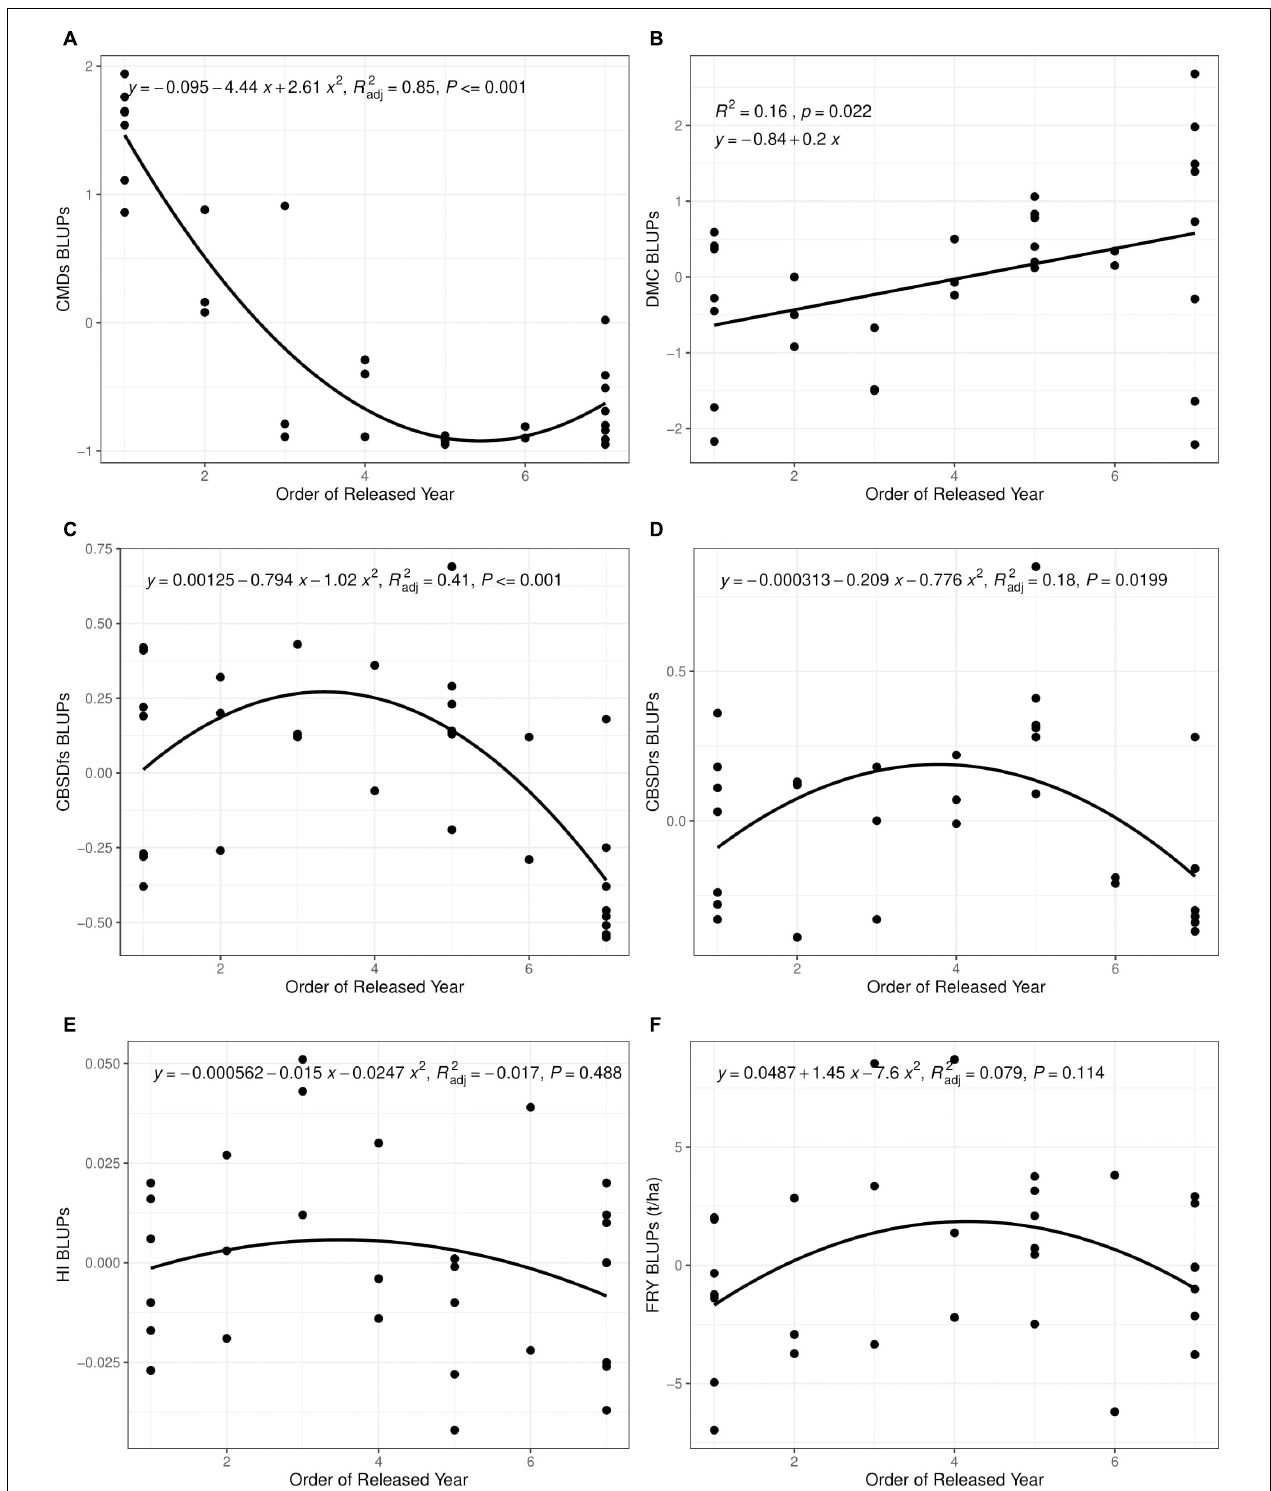
FIGURE 1 | Changes in yield and disease severity for 32 varieties released and/or developed between 1940 and 2019 in Uganda. (A) Cassava mosaic disease severity at 6 months after planting (CMDs). (B) Dry matter content (DMC). (C) Cassava brown streak disease foliar severity at 6 months after planting (CBSDfs). (D) Cassava brown streak disease root necrosis severity at 12 months after planting (CBSDrs). (E) Harvest index (HI). (F) Fresh root yield (FRY). CBSD resistance breeding was initiated in fourth released year (2003).